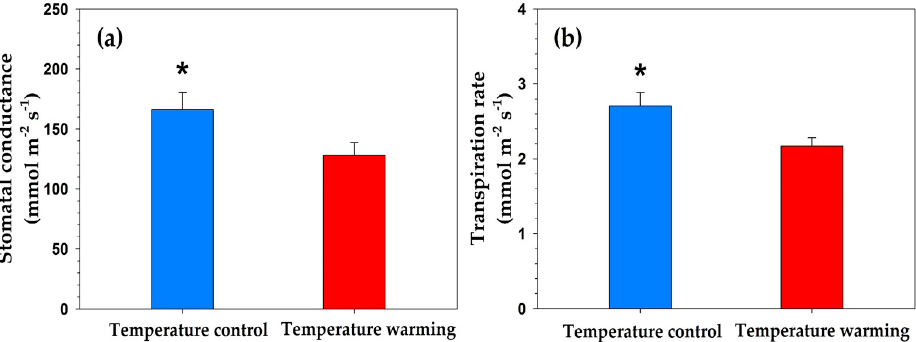
Figure A1. Effect of warming on ( a ) stomatal conductance and ( b ) transpiration rate of Pinus densiflora seedlings in 2014.